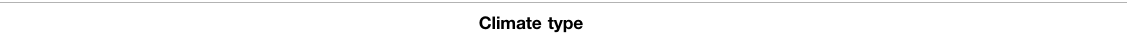
TABLE 2 | Climate types and soil units used to determine edaphoclimatic diversity patterns.